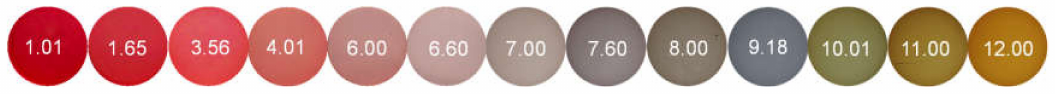
Figure 4. E ff ect of pH on the color of anthocyanin solutions. The pH values of the solutions are indicated for each color.